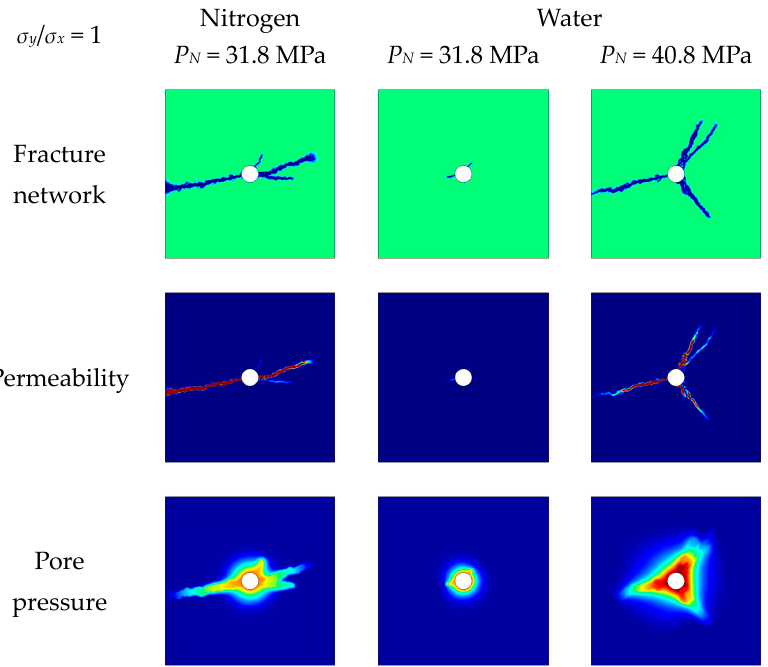
Figure 11. Fracture network evolution and related responses during the water and nitrogen fracturing